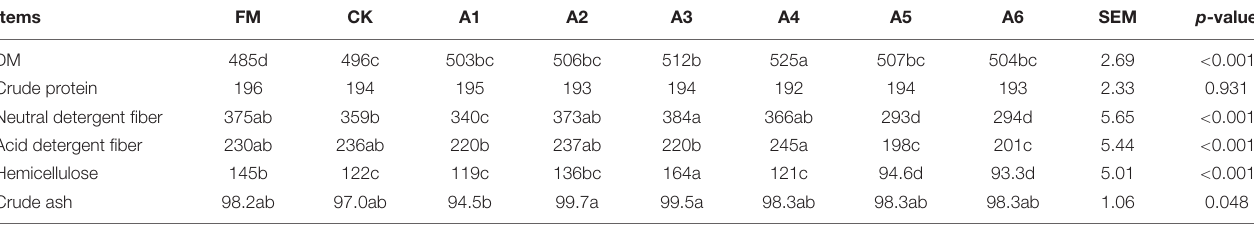
TABLE 2 | Dry matter (DM, g/kg) and nutrition composition (g/kg DM) of alfalfa silages ( n = 4).